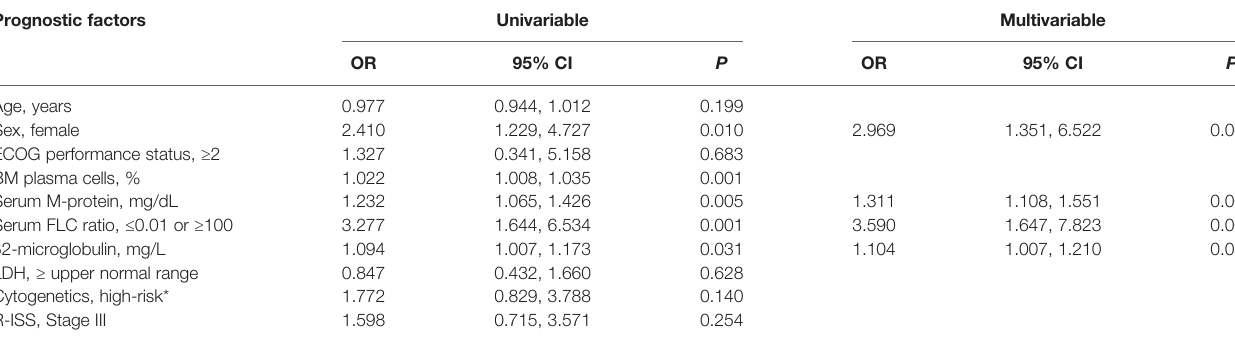
TABLE 2 | Univariable and Multivariable analyses for high CRBN expression prediction. Prognostic